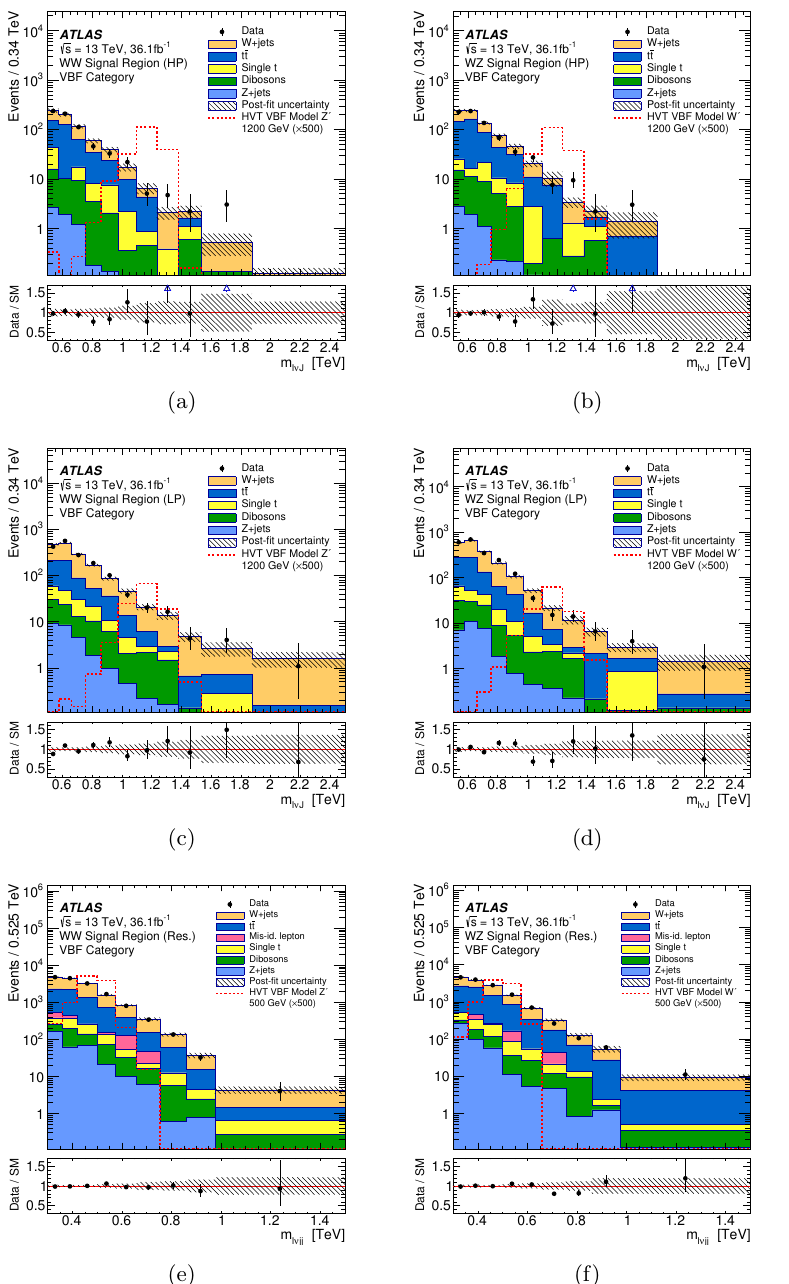
Figure 4 . Post-(cid:12)t signal region m ( WV ) distributions in the VBF category. The merged high- purity (HP) sample of (a) WW and (b) WZ events, the merged low-purity (LP) sample of (c) WW and (d) WZ events and the resolved (Res.) sample of (e) WW and (f) WZ events are presented. The expected background is shown after the pro(cid:12)le likelihood (cid:12)t to the data, and signal predictions are overlaid, normalized to the cross sections indicated in the legends. The VBF HVT signal at 1200 GeV is presented for the merged analysis, while the 500 GeV signal is shown in the resolved topology. The band denotes the statistical and systematic uncertainty in the background after the (cid:12)t to the data. The lower panels show the ratio of the observed data to the estimated SM background. The distribution of events is shown per mass interval corresponding to the penultimate bin width, while the over(cid:13)ow events are included in the last bin.